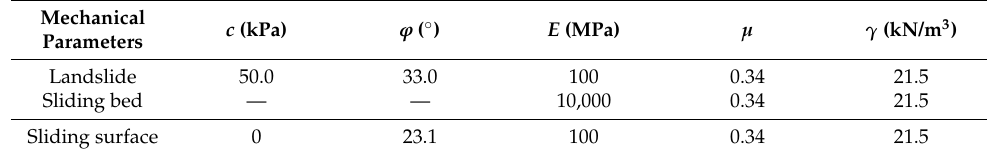
Table 3. Parameters for MPM model calculations.